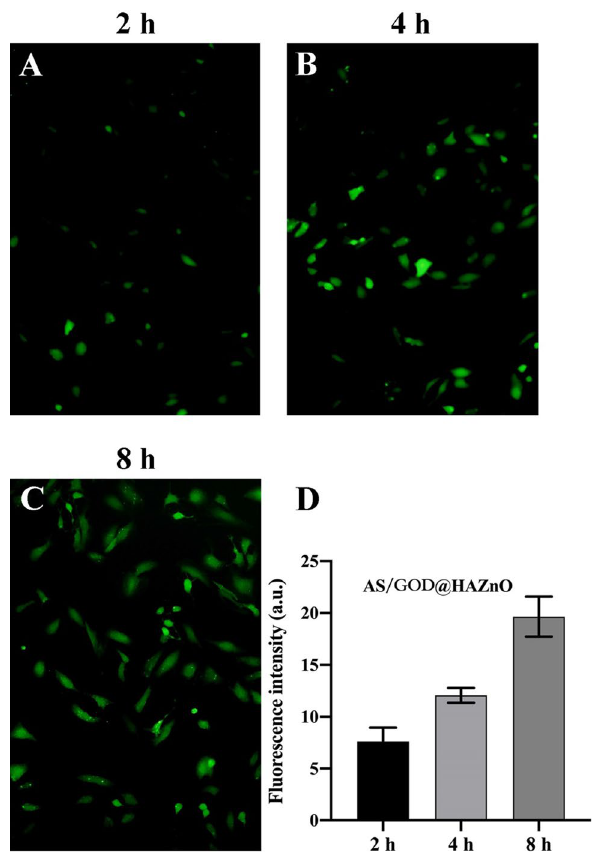
Figure 6. Fluorescence images indicate the intracellular ROS level of 4T1 cells after incubation with AS/GOD@ HAZnO for 2 h, 4 h, and 8 h, respectively. Data are presented as mean ± SD, n = 3. Scale bar = 100 μm.